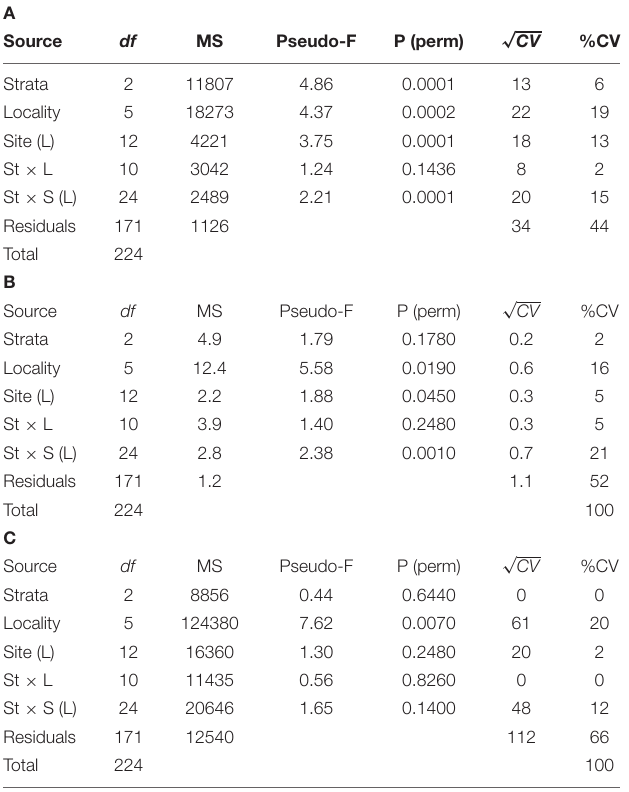
(A) Structure of assemblages using Bray-Curtis dissimilarities over natural logarithms (+1) of abundances, (B) Density of species per core, (C) Density of individuals per core. The square root of the components of variation, as well as their relative importance, are presented.